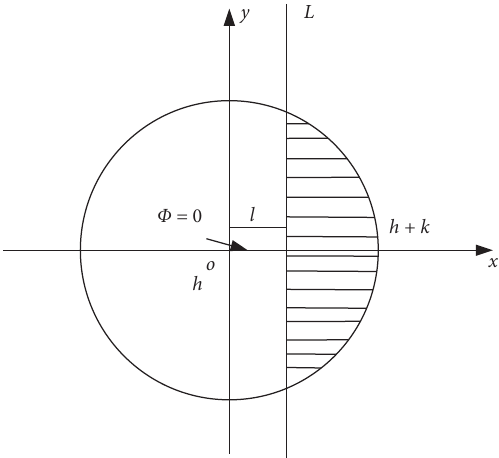
Figure 1: Subpixel edge image model.